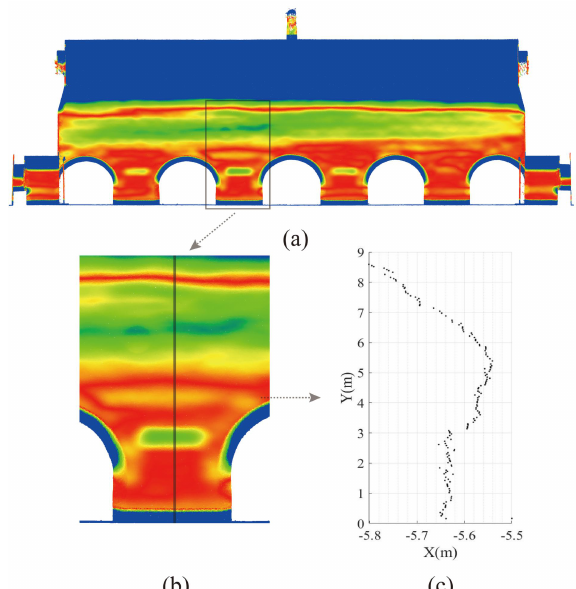
Figure 5. Analyzing the lateral displacement of the south wall under CVT. Chromatically scaled point cloud globally (a) and locally (b); and (c) a point slice with S-shape distortion.